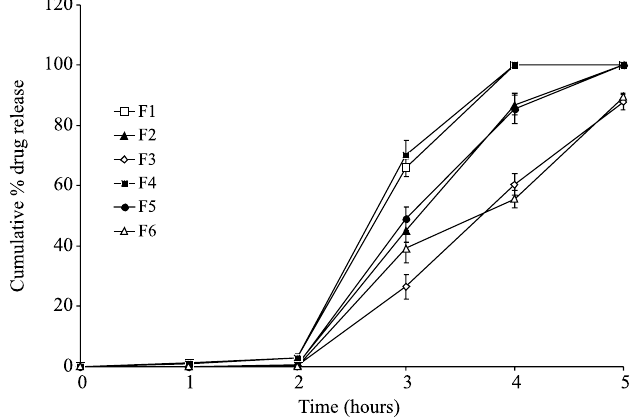
FIGURE 8 - Dissolution study of enteric coated pellets. (mean ± SD, n = 3).